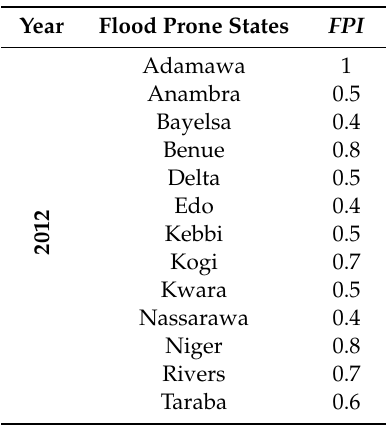
Table 3. GRACE-based FPI values for the flood-prone / worst-hit states in September